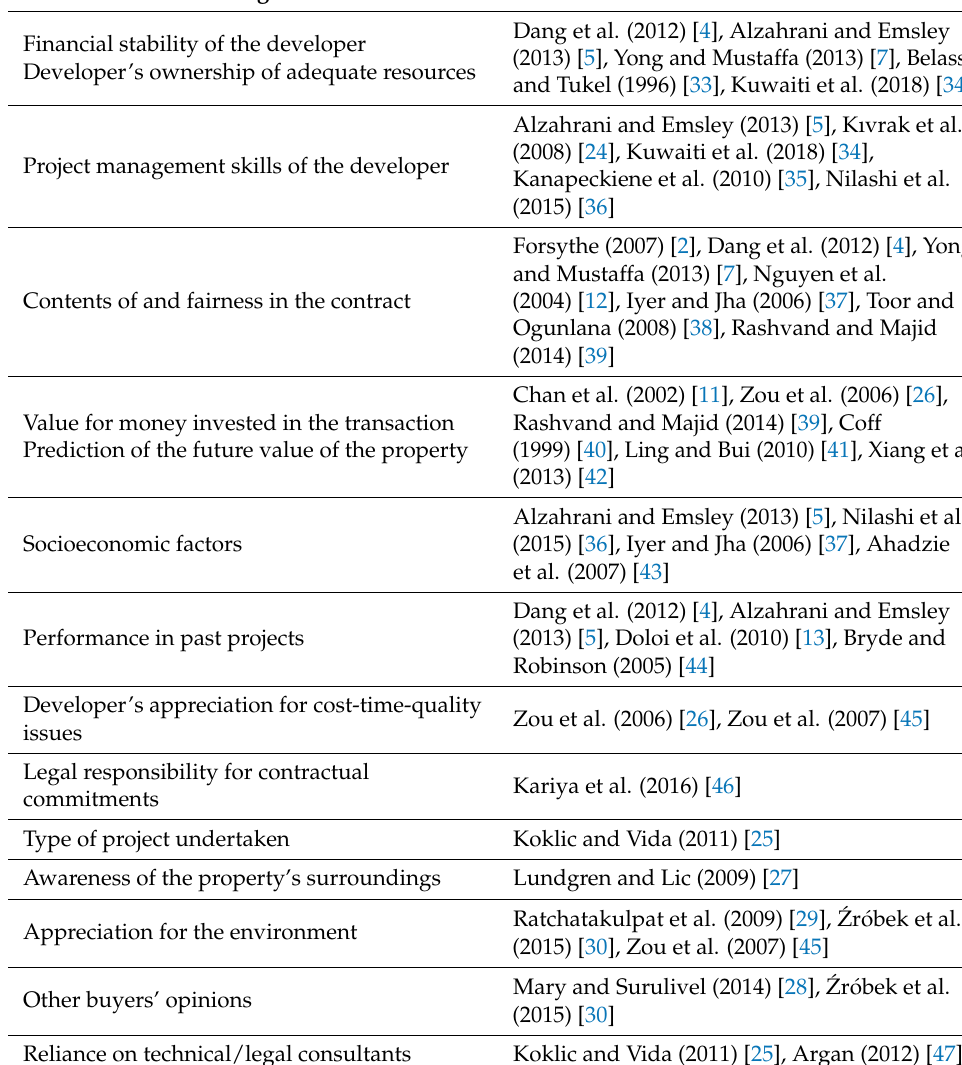
Table 2. Knowledge items used by home